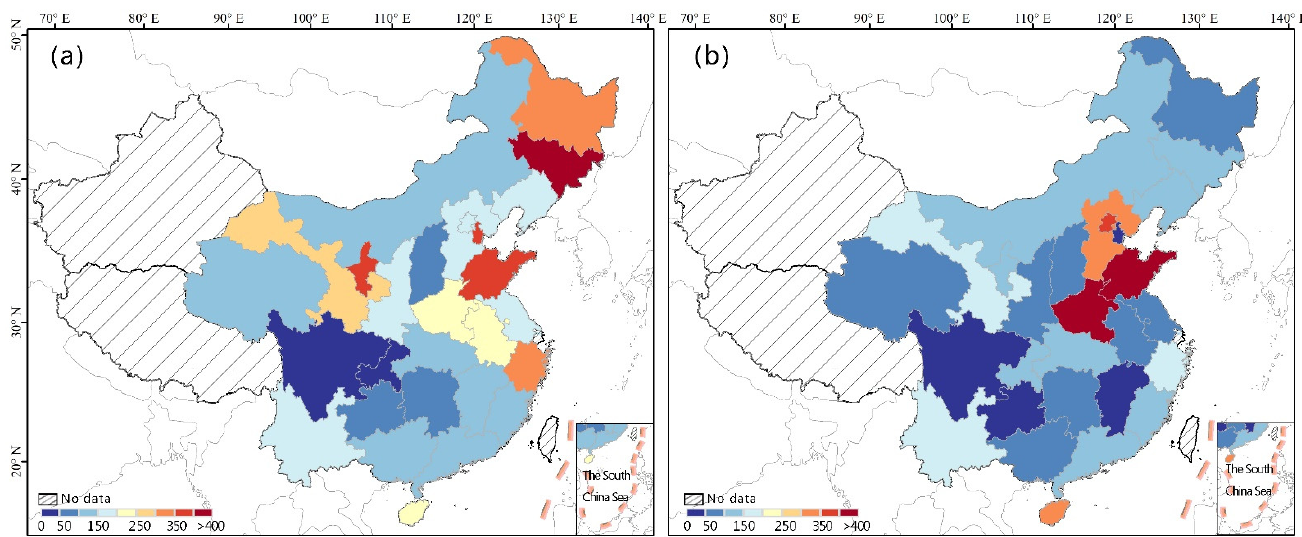
Figure 4. Current status of land costs by province in China. ( a ) Explicit cost of land (yuan/mu); ( b ) implicit cost of land (yuan/mu).